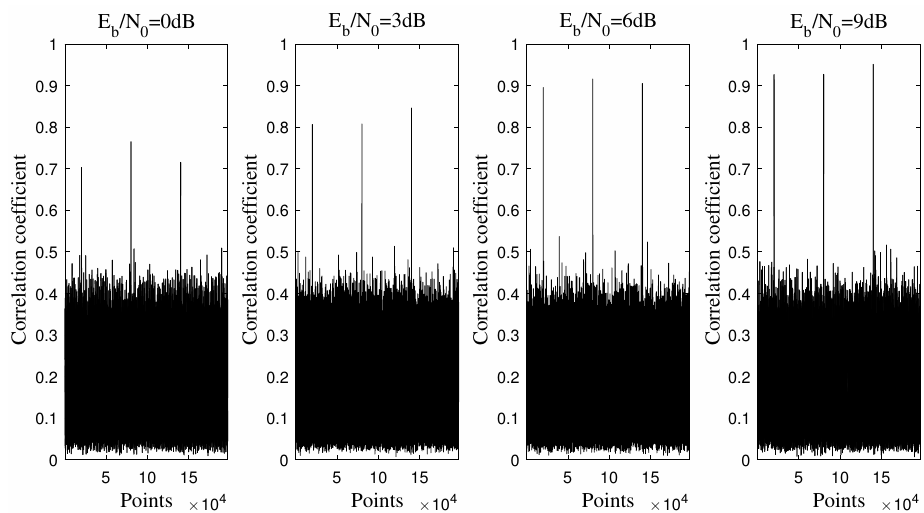
Figure 10. The correlation coefficient curves obtained by DUWDC in the case of f e T = 0.1.